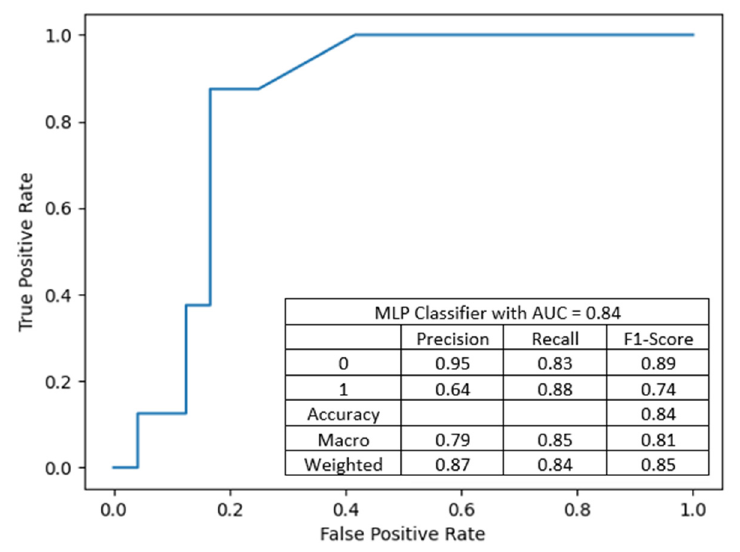
Figure 11. An artificial neural network based on multi-layer perceptron: the classifier is the only one with greater sensitivity to the presence of DGF than to the absence of DGF. The combination of this model and the previous one can still be a prognostic tool.